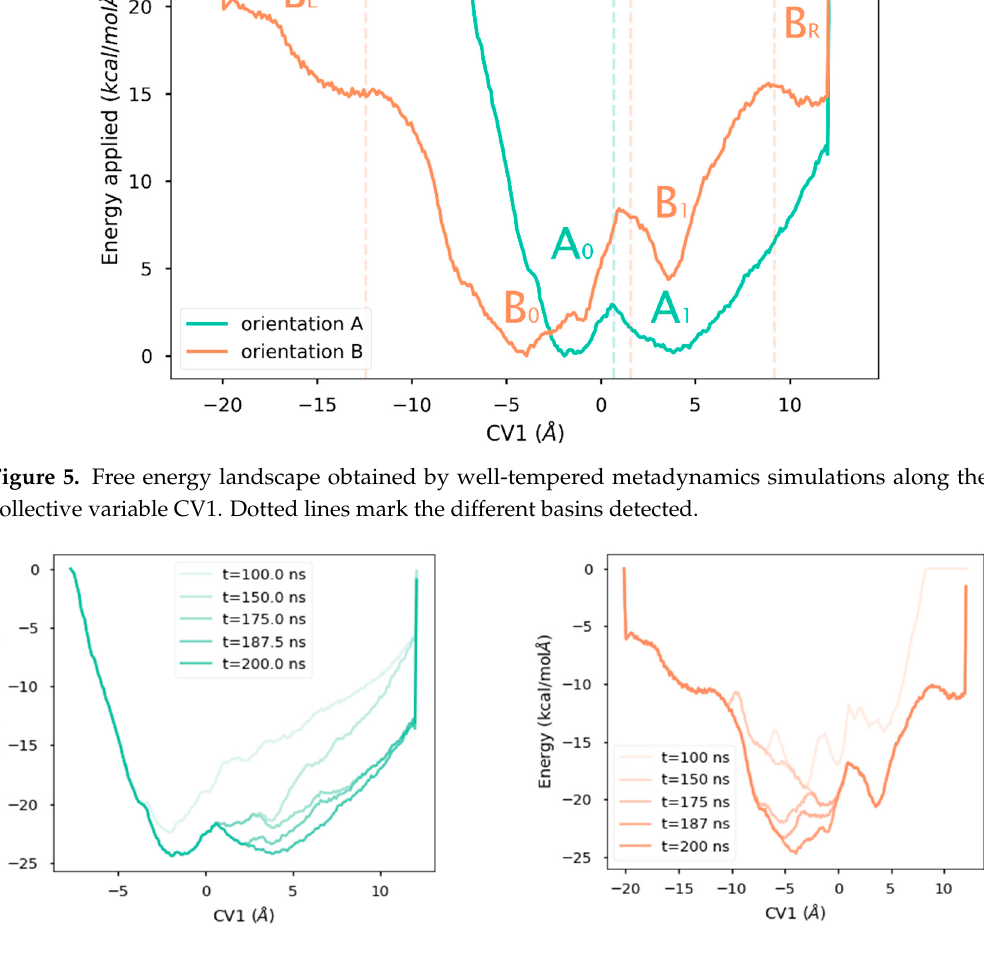
Figure 6. Convergence of metadynamics simulations illustrated as energy deposition along time in diffusion axis. Latest contributions added little energy to the landscape. ( a ) Energy landscape for the the diffusion axis. Latest contributions added little energy to the landscape. a ) Energy landscape for orientation A. ( b ) Ibid. for the orientation the orientation A. b ) Ibid. for the orientation B.